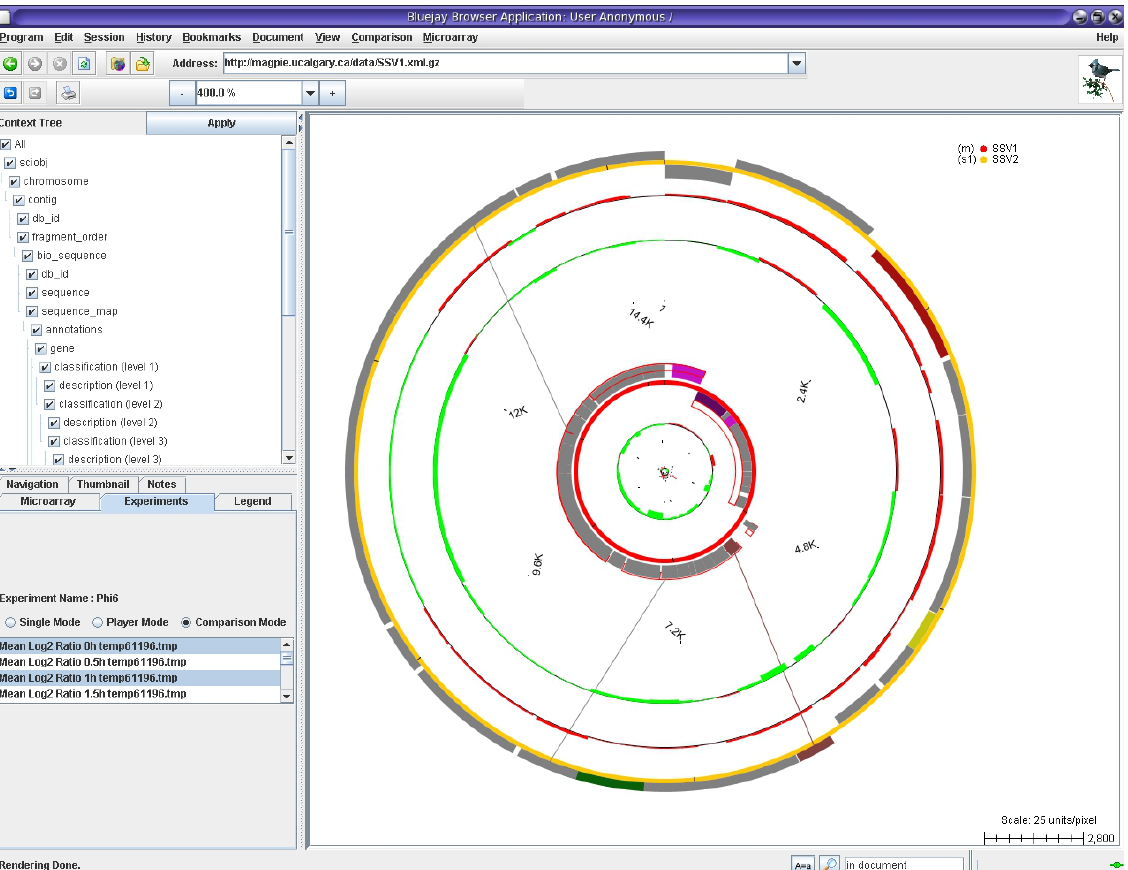
Figure 4: Multiple microarray datasets for multiple genomes are displayed. SSV1 is loaded as master and SSV2 loaded as slave1. Datasets loaded correspond to 0 and 1 hour for both